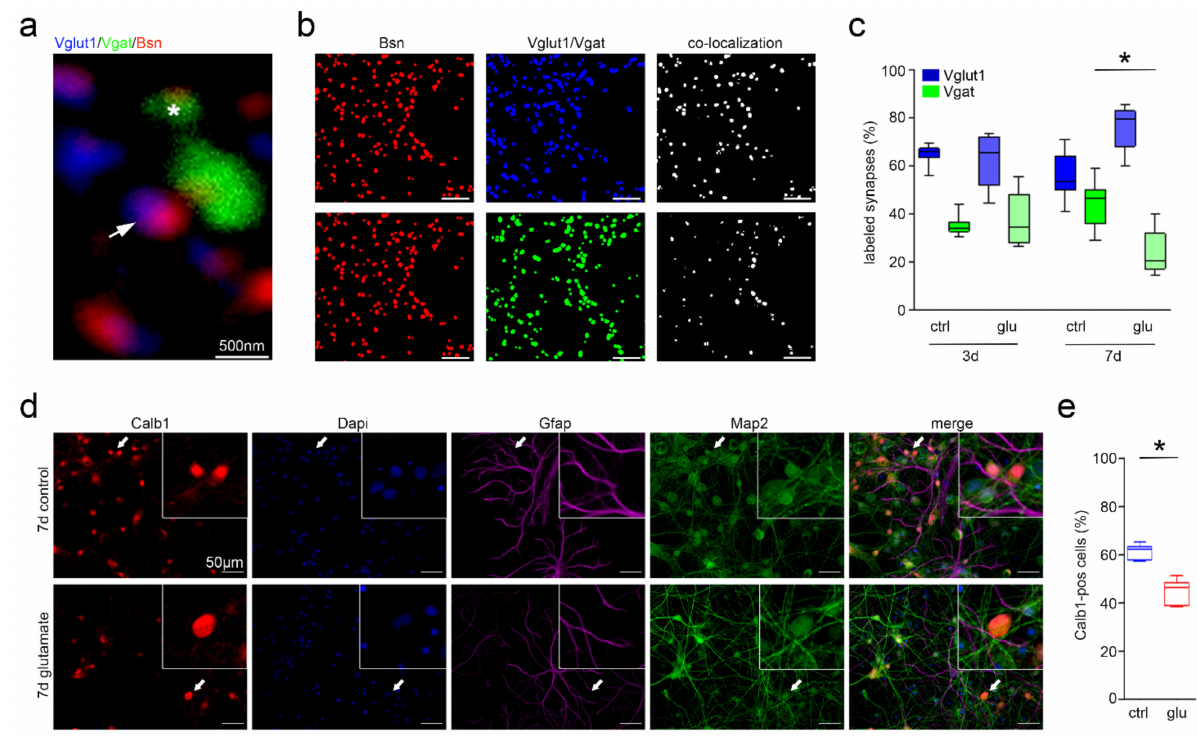
Figure 3. Relative loss of GABAergic synapses and Calbindin-immunoreactive cells. ( a ) Glutamatergic and GABAergic synapses were stained with Vglut1 (blue, white arrow) and Vgat (green, asterisk), respectively, for manual and auto- mated quantification. Only synapses showing co-localization with Bsn (red) were counted. Confocal microscopy at 63 × . ( b ) Processed immunofluorescence images for pre- and post-synapses of Fiji plug-in “Synapse Counter” and resulting co-localizations. Scale bars are 500 nm. ( c ) Relative quantification of GABAergic over glutamatergic synapses at 3 and 7 days after glutamate treatment as compared with time-matched sham-treated controls. ( d , e ) Relative amount of Calb1-positive neurons compared with Calb1-negative neurons in glutamate and sham-treated cultures after 7 days. Asterisks (*) indicate significance. ctrl—control, d—day,